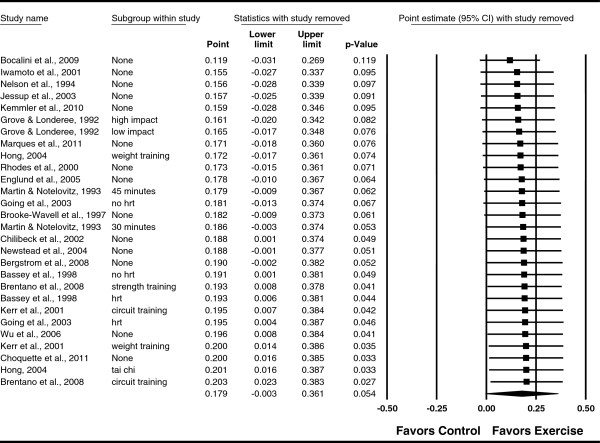
Influence analysis for changes in LS BMD. Influence analysis for point estimate standardized effect size changes (g) in LS BMD with each corresponding study deleted from the model once. The black squares represent the standardized mean difference (g) while the left and right extremes of the squares represent the corresponding 95% confidence intervals. The middle of the black diamond represents the overall standardized mean difference (g) while the left and right extremes of the diamond represent the corresponding 95% confidence intervals. Results are ordered from smallest to largest values of g. For subgroup, HRT means hormone replacement therapy.